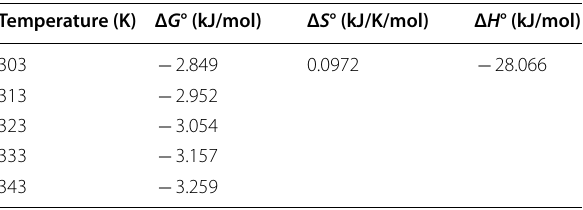
Table 5 Thermodynamic parameters for Cr (VI) bioreduction by Tamarindus indica methanol leaves extract at pH 7